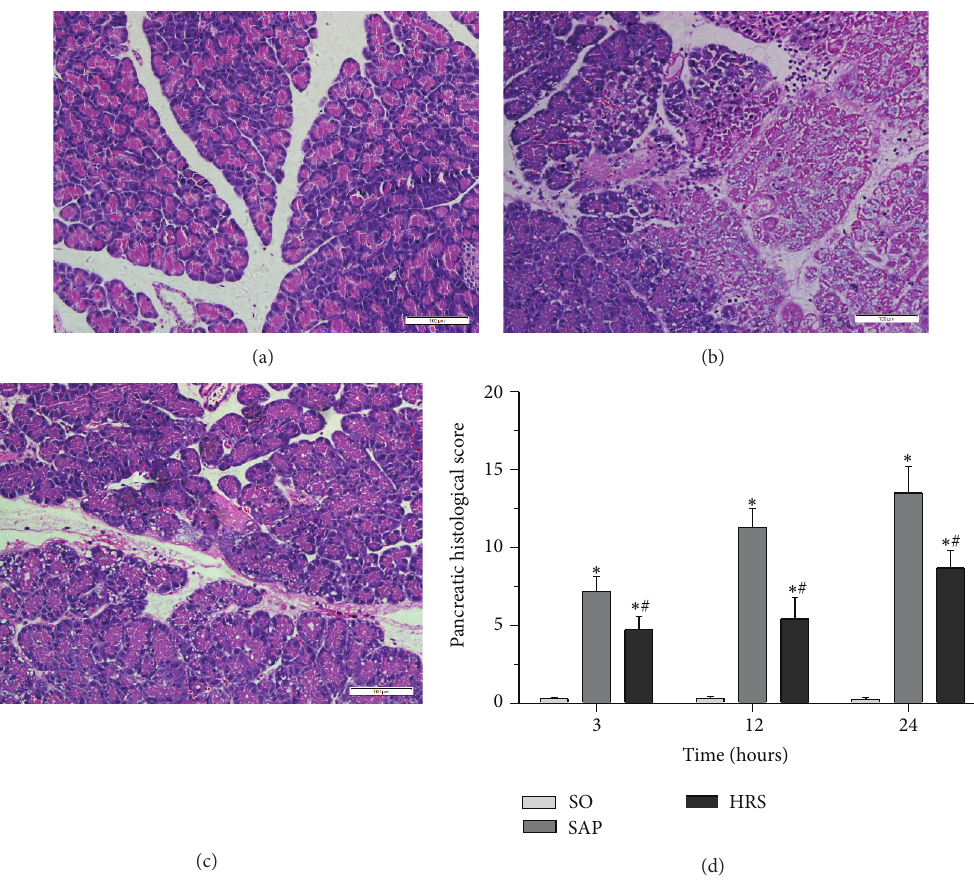
Figure 2: Morphologic changes of pancreas at 12 hours and the pancreatic histological scores at each time point. (a) SO group, (b) SAP group, (c) HRS group, and (d) pathological scores of pancreas at each time point. ∗ 𝑃 < 0.05 versus SO group; # 𝑃 < 0.05 versus SAP group. The figure is representative of at least 3 experiments performed on different experimental days (original magnification ×